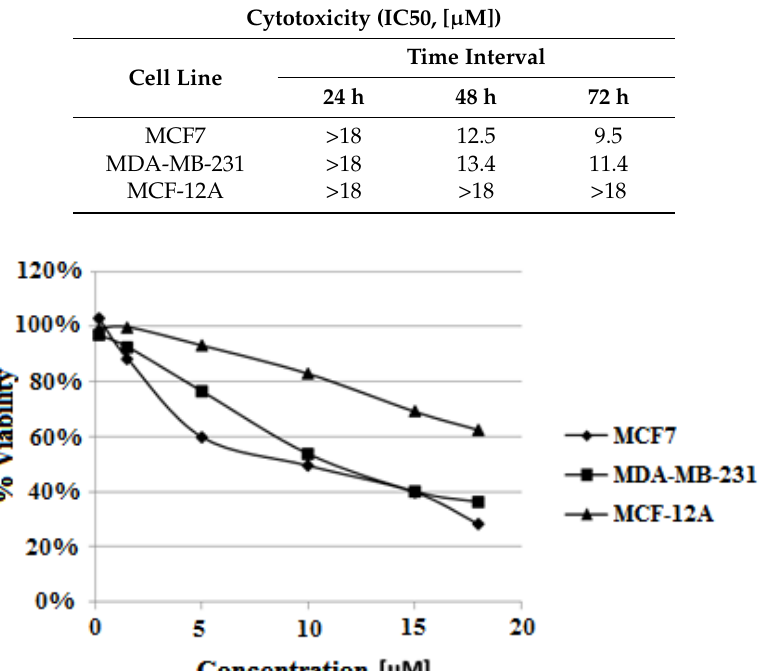
Figure 12. Dose–effect curves for studied cell lines treated with different concentrations of compound 3 (concentration range of 0.15–18 μM) for 72 h.